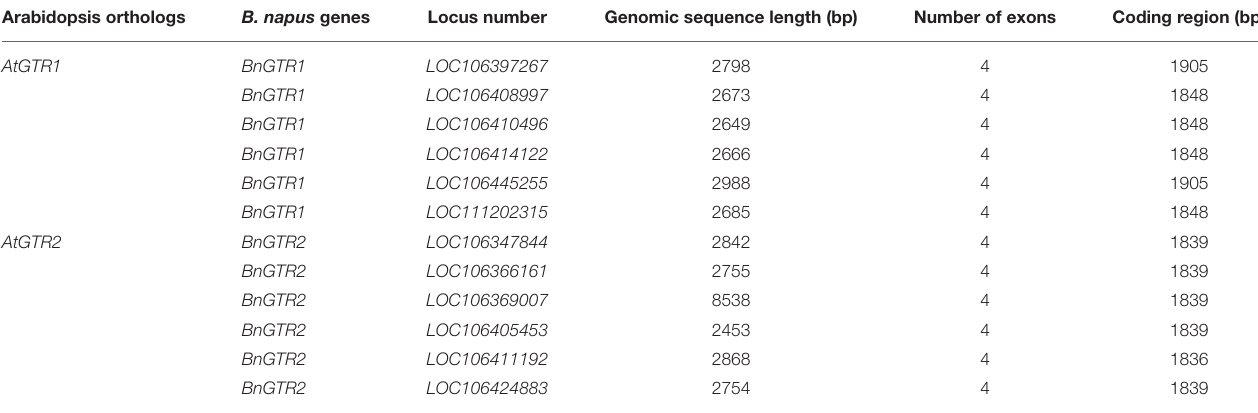
TABLE 8 | Features of the BnGTR paralogs used in this study. Arabidopsis orthologs